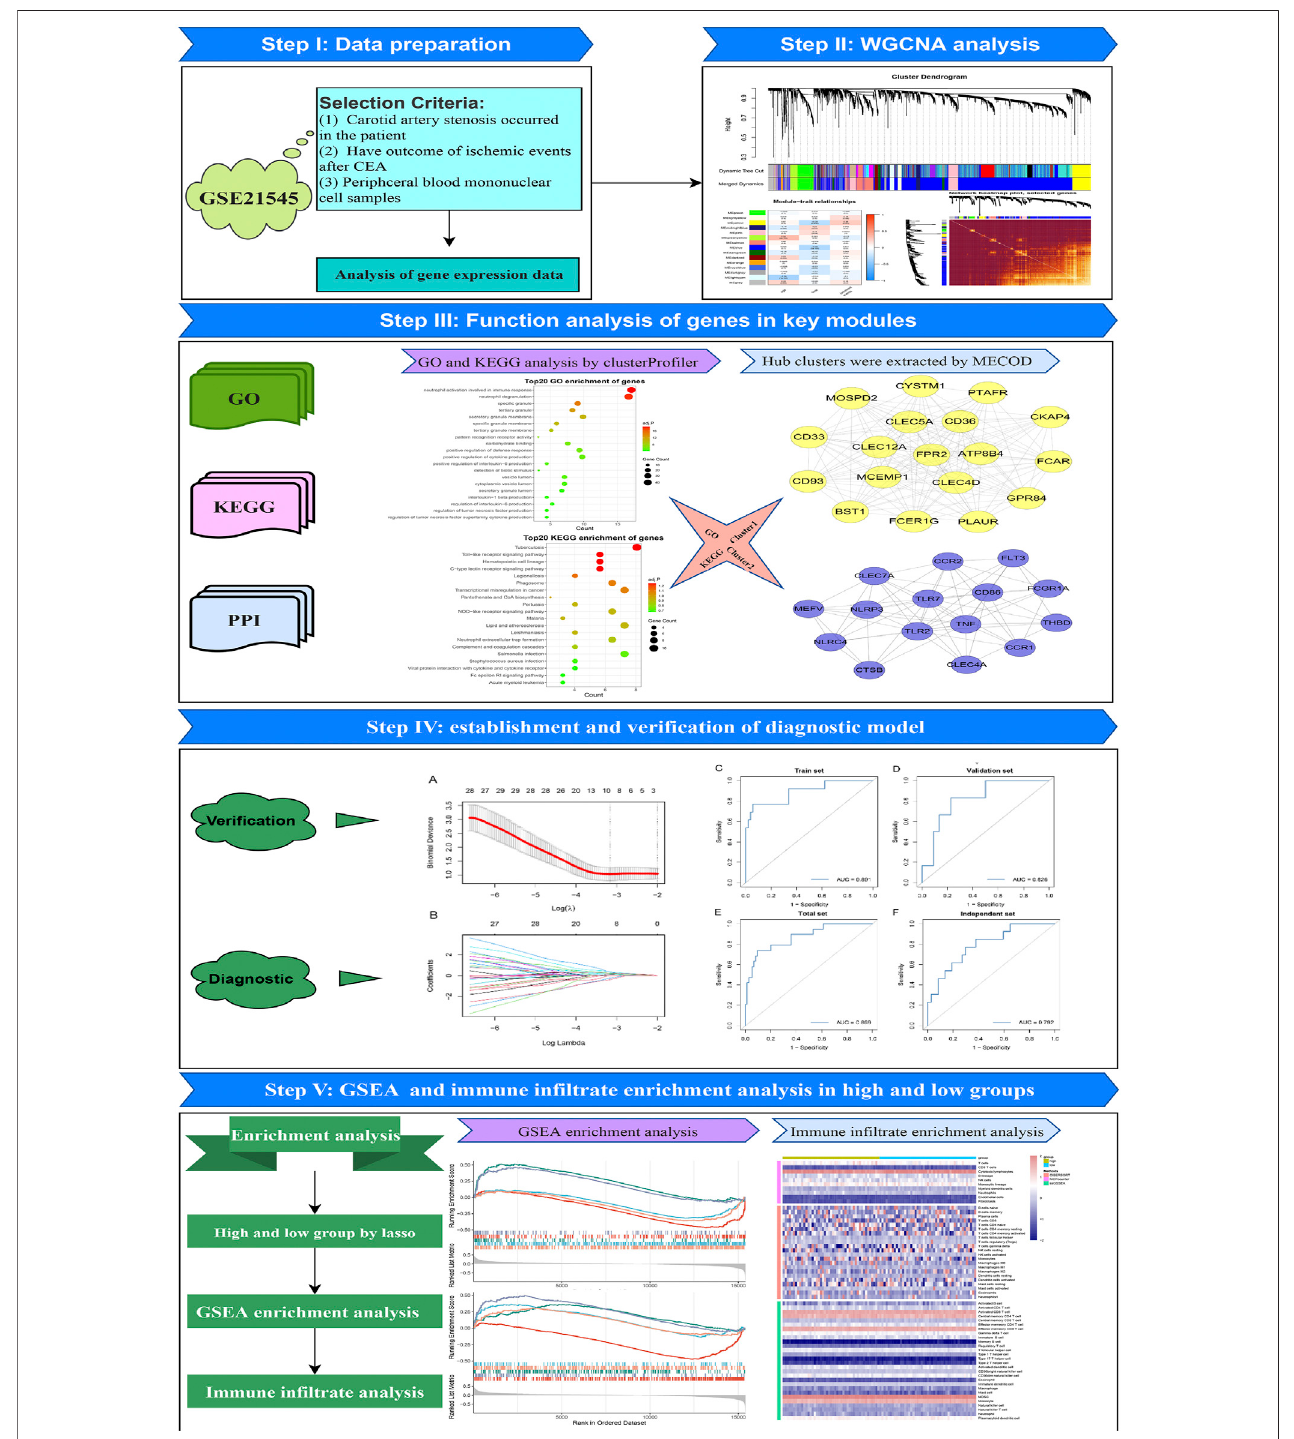
FIGURE 1 | Flowchart of the analysis